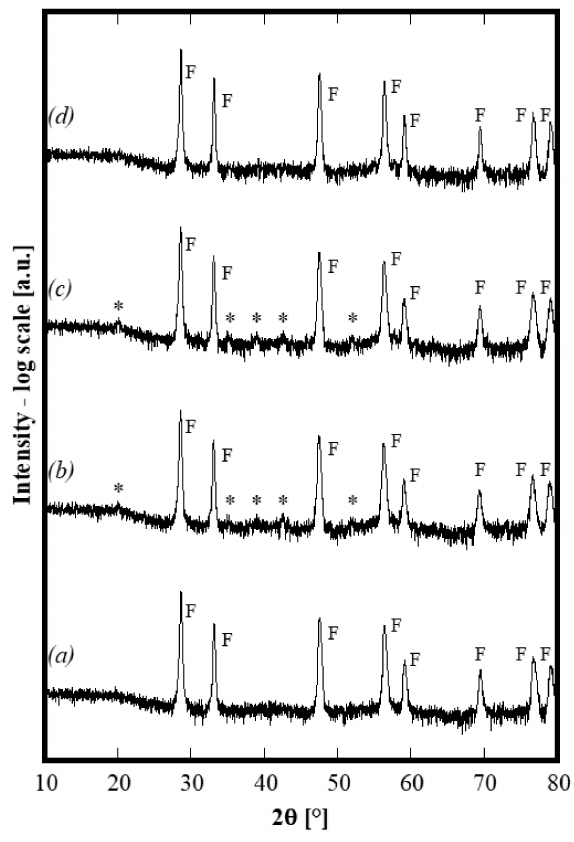
Figure 4. Di ff raction patterns of same sample CeZrYGdLa-N first annealed at 1500 ◦ C (pattern a ),